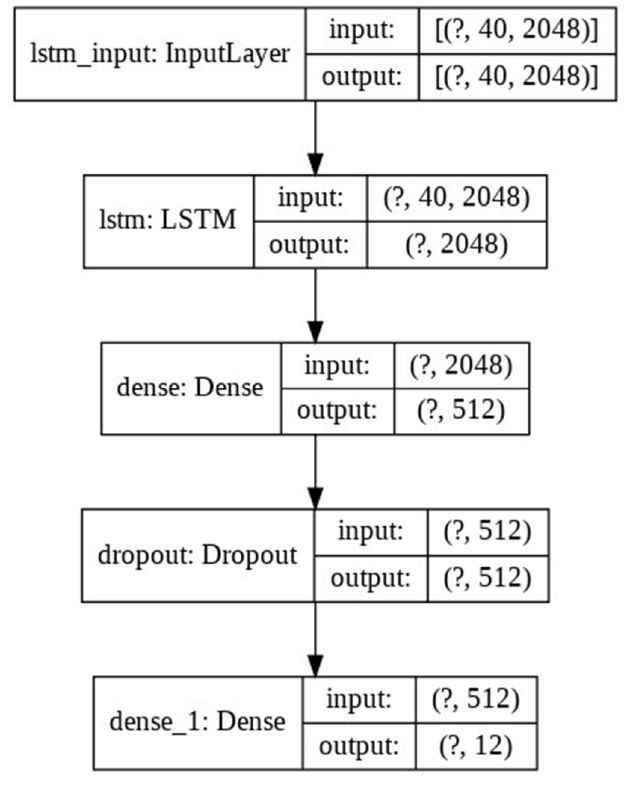
Figure 3. The LSTM model architecture.